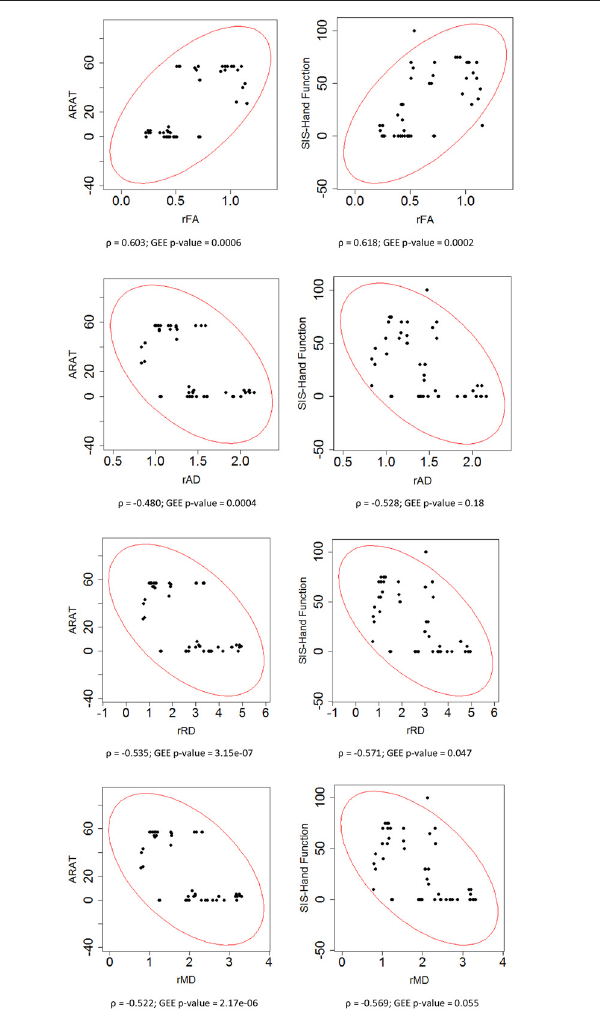
FIGURE 3 | Correlation of ratios of each DTI measure and motor outcomes across time. Each ratio of DTI measures was correlated with motor outcome measures including ARAT and SIS hand function scores assessed in impaired hand. Spearman rank correlation coefficient ( ρ ) and the statistical significance of correlation (GEE p -value) are